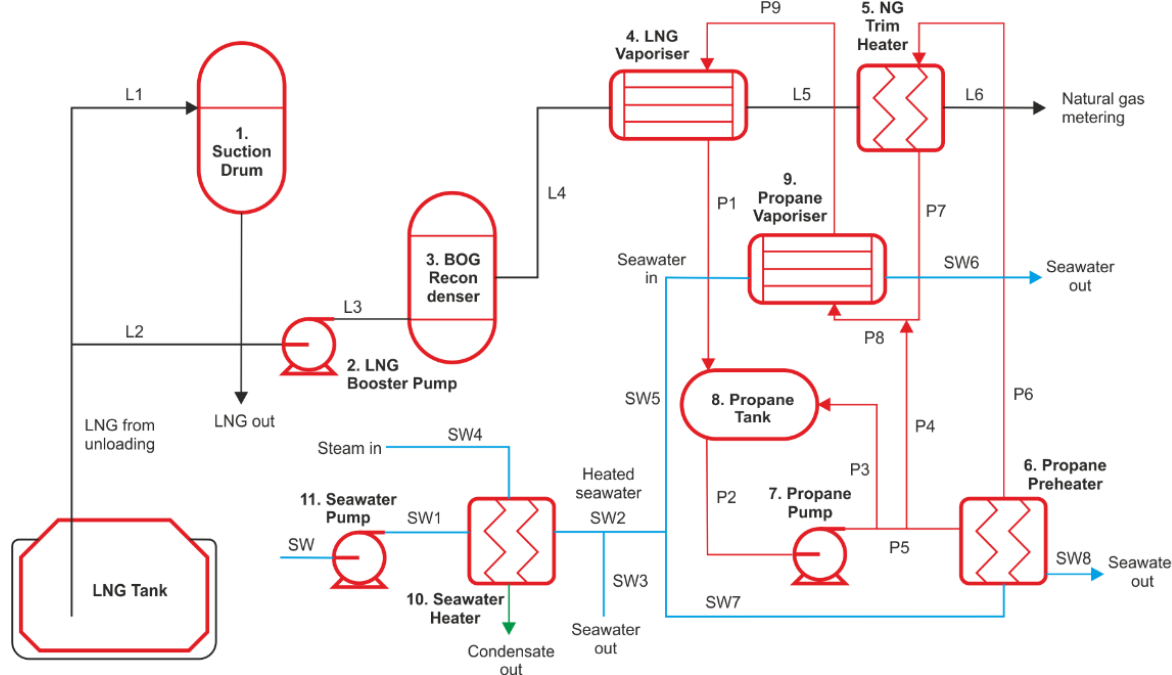
Figure 1. Simplified scheme of regasification process in FSRU. Note: the suction drum, including in- and outputs L1, L2, L3, and B1, is presented to illustrate the completeness of regasification process scheme; however, in the presented study these elements will not be analysed in detail.